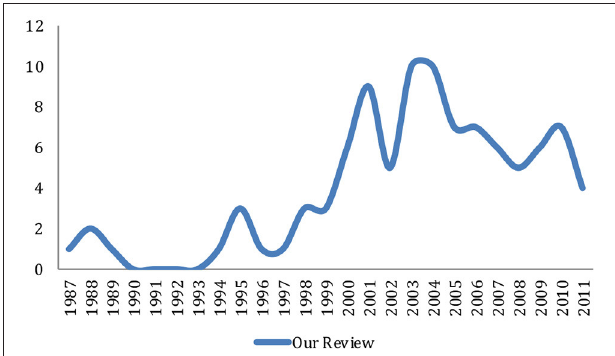
FIGURE 2 | The distribution of publications included in the review from 1988 to